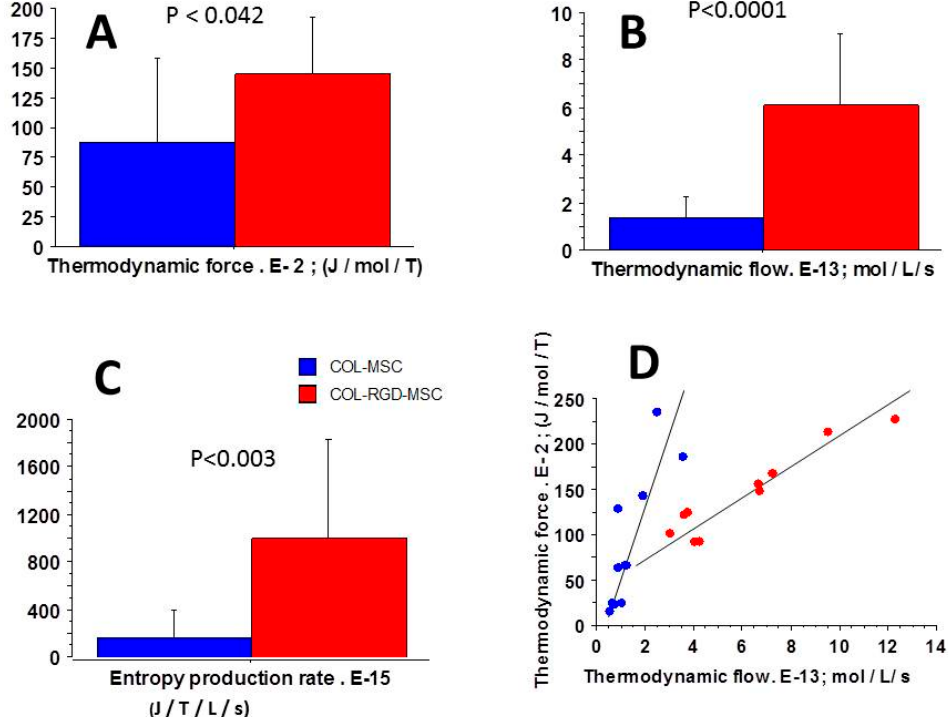
Figure 3. Parameters of statistical mechanics. ( A ): Thermodynamic force; ( B ): Thermodynamic flow; ( C ): Entropy production rate. These three parameters were significantly greater in COL-MSC-RDG sca ff olds (red) than in COL-MSC sca ff olds (blue); ( D ): There was a linear relationship between the thermodynamic force and the thermodynamic flow showing that both the 2 types of contractile sca ff olds behaved in a stationary mode; y = − 5 + 68 x; r = 0.84 in COL-MSC sca ff olds; y = 48 + 15 x in COL-MSC sca ff